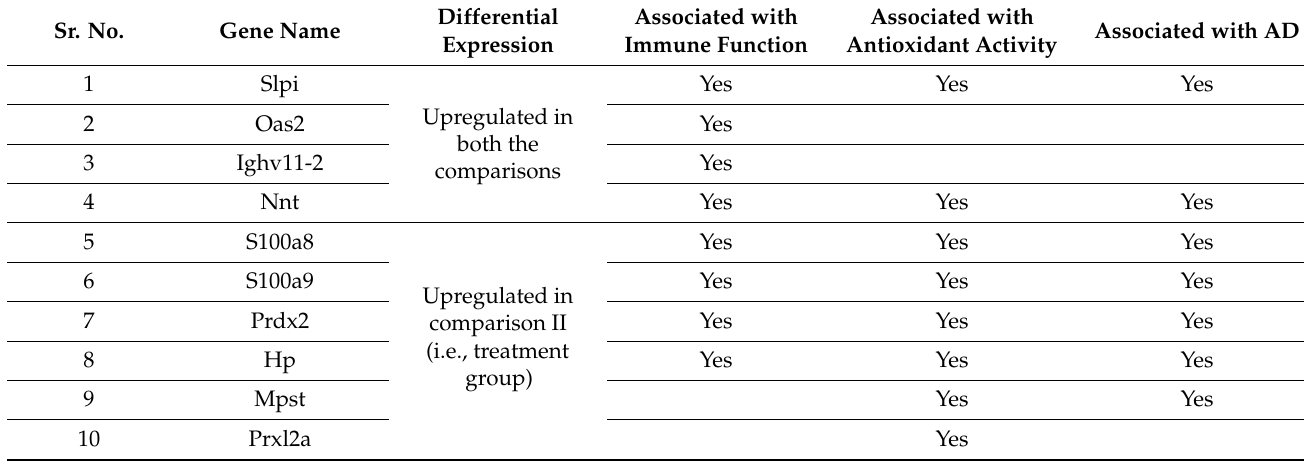
Table 2. Differentially expressed genes proposed to be important candidate in C3G -induced antioxidant and/or immune modulation